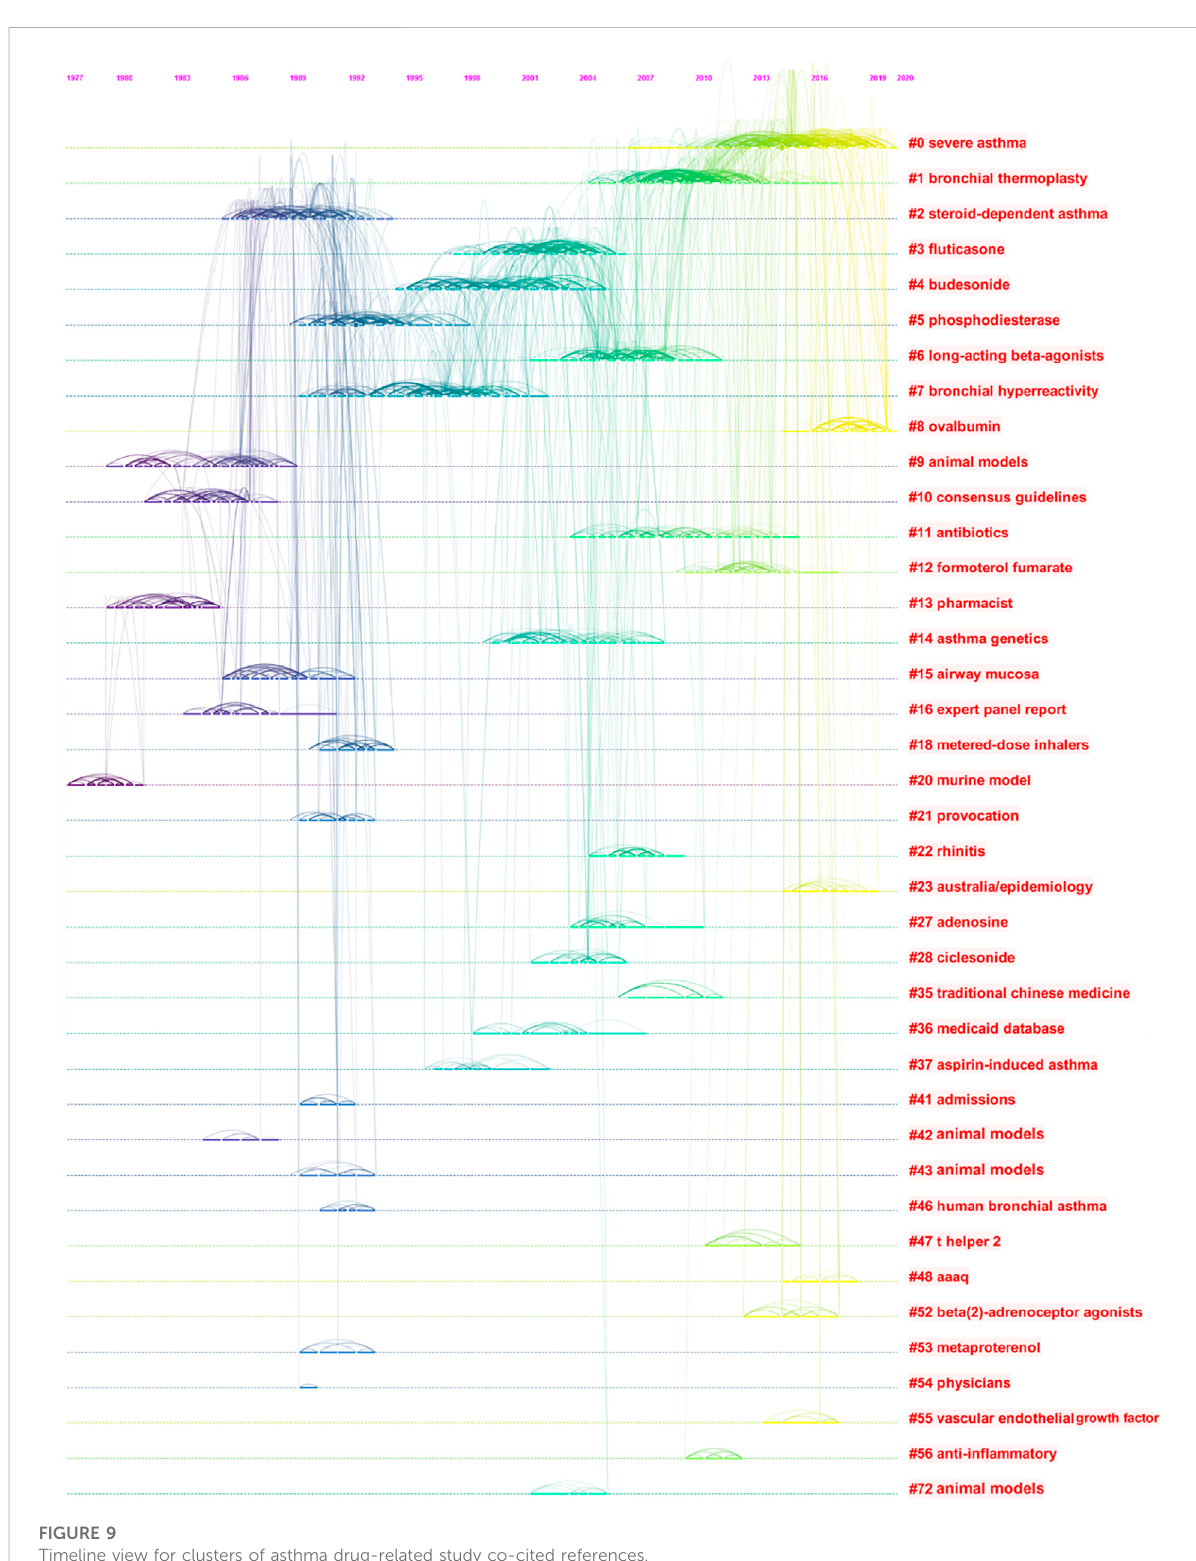
FIGURE 9 Timeline view for clusters of asthma drug-related study co-cited